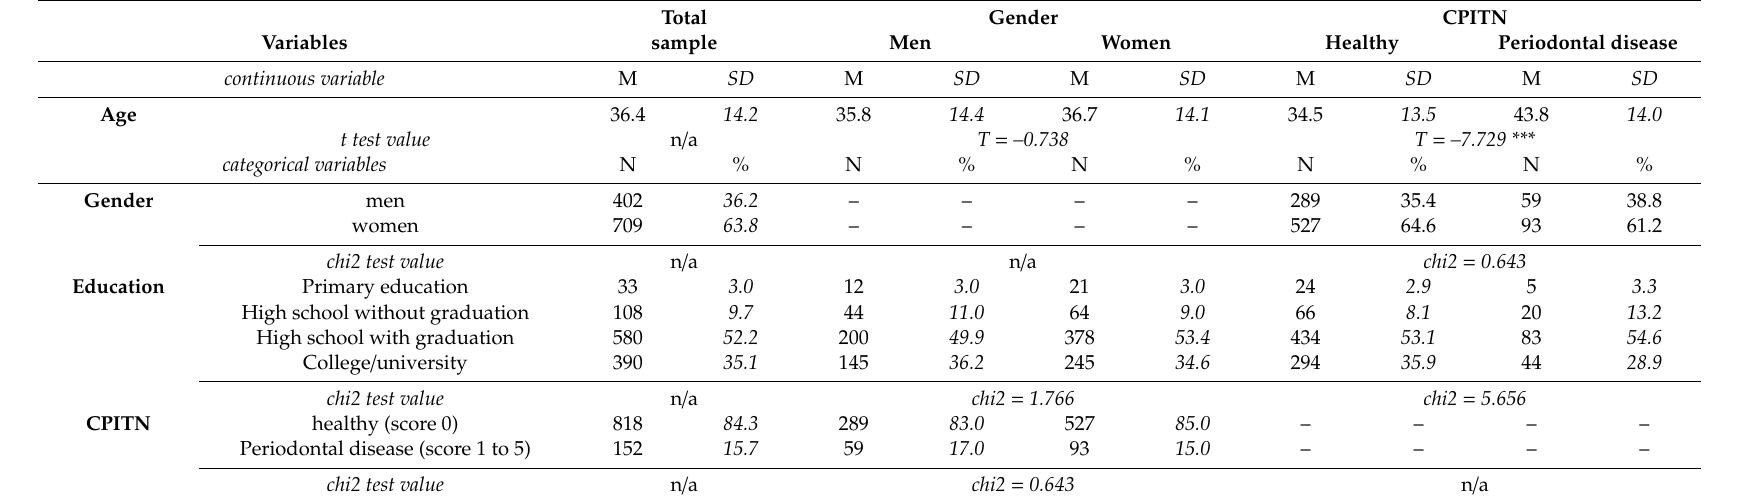
Periodontal disease (score 1 to 5)